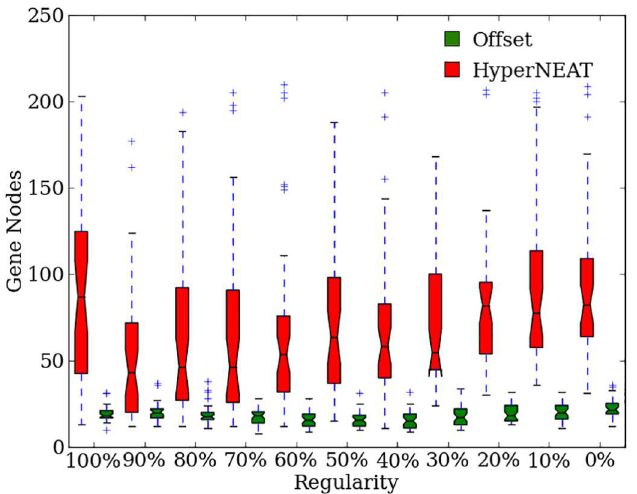
Fig 9. The target weights experiment genome sizes for HyperNEATand Offset-HybrID. The number of nodesin the CPPN genomeof HyperNEAT and Offset-HybrID run championsafter 2,000 generationson the target